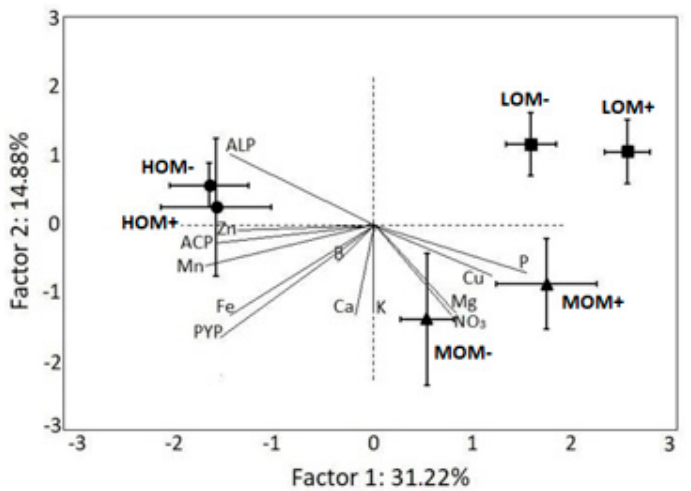
Figure 6. Ordination of the soil samples according to the soil physicochemical variables and enzyme activities on a PCA biplot. Each point corresponds to the mean value of the loadings of the eight samples belonging to the same treatment, at the first and the second axis; the first symbol corresponds to the organic matter content (LOM: low, MOM: medium, HOM: high), and the second to the specific irrigation regime (+: irrigation, -: no irrigation). Error bars indicate standard errors for both axes (n = 8).